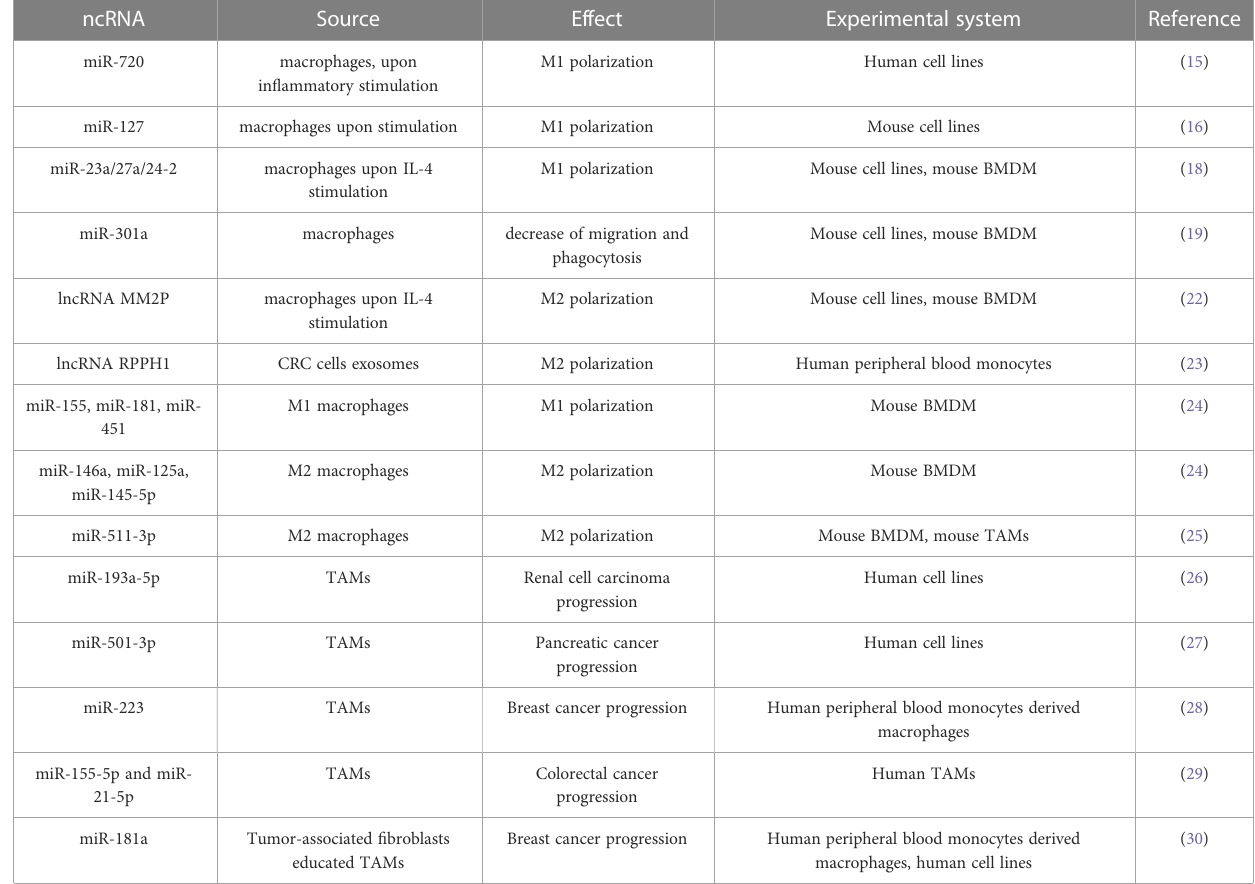
TABLE 1 ncRNA in macrophage polarization and TAM-tumor cells